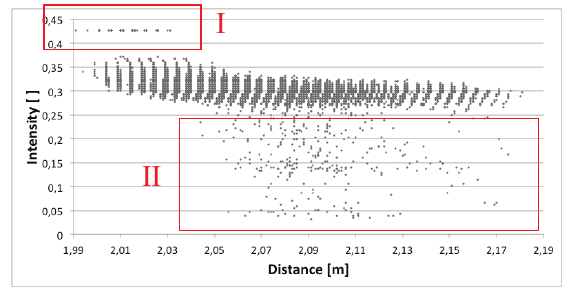
Figure 4. Intensity distribution (range: 2 m; standard target)